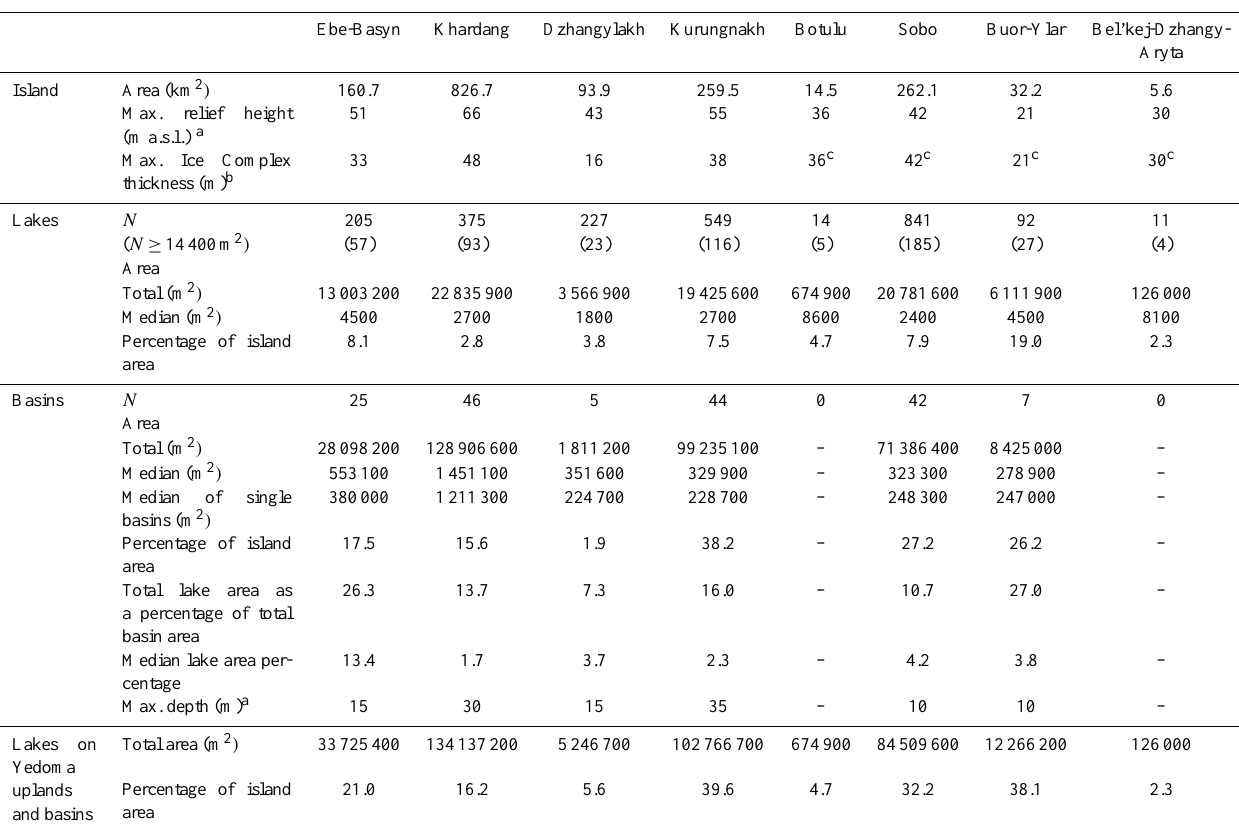
Table 7. Comparison of thermokarst features and permafrost characteristics between major islands of the study area.